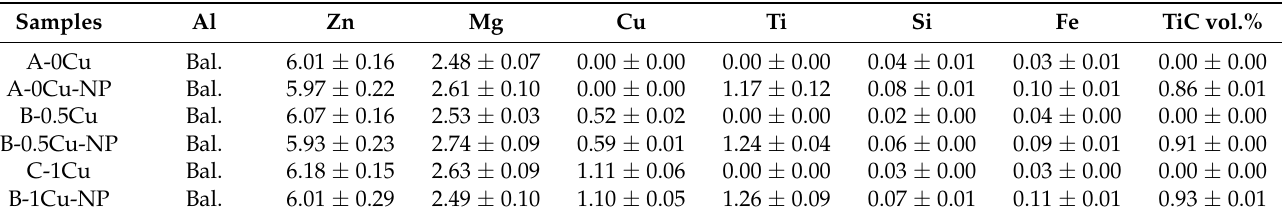
Table 1. Sample names and composition (unit.